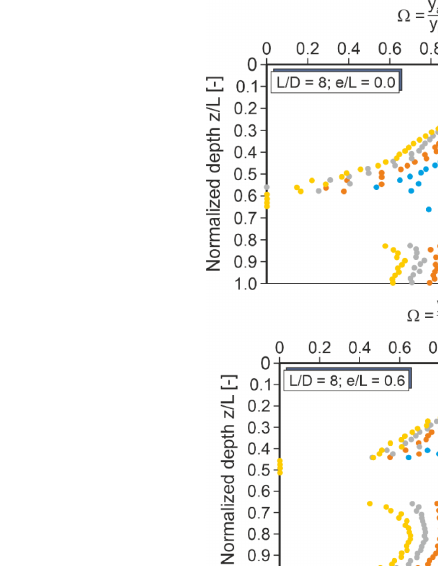
pile ( L/D = 5–8), N is cycle numbers ( N = 1 − 10000) and e is load eccentricity ( e/L = 0 . 0 − 1 .